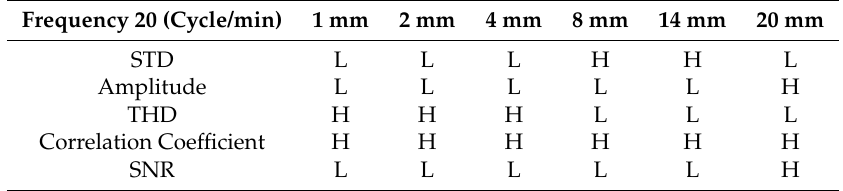
Table A14. Values higher and lower than the median Frequency 20 cycles/min for a 5 mm band.